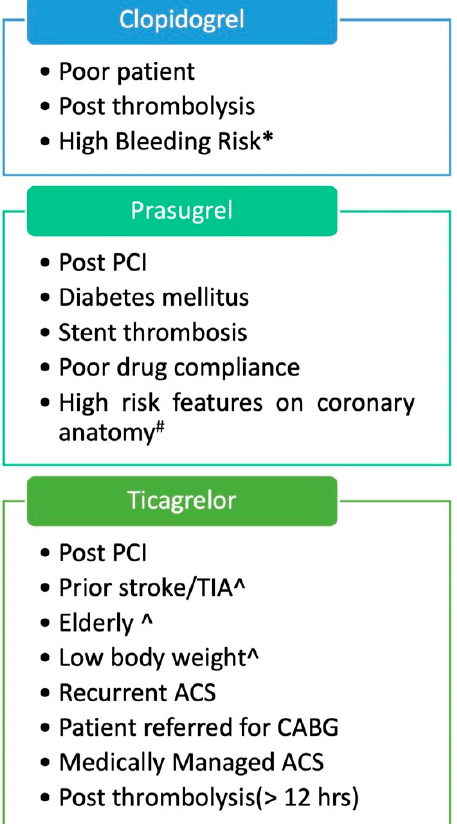
Figure 2. Suggested choice of P2Y12 inhibitor therapy according to clinical scenario based on the available clinical evidence. (^ A lower loading dose of 30 mg and maintenance dose of 5 mg can be utilized for prasugrel as also done in ISAR REACT-5. # Left main coronary disease, bifurcation, chronic total occlusion, sole surviving vessel. * PRECISE-DAPT or PARIS bleeding score should be used. A “De-escalation” strategy with initial course of prasugrel/ticagrelor for the first few weeks after ACS followed by clopidogrel has now been successfully tried).